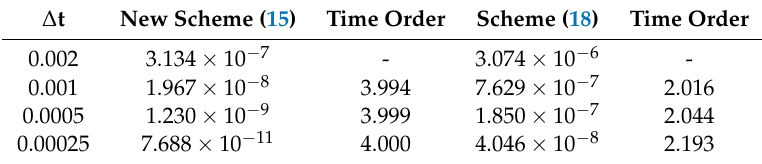
Table 1. Time accuracy test for the scheme (15) and the scheme (18) at t = 0.1.